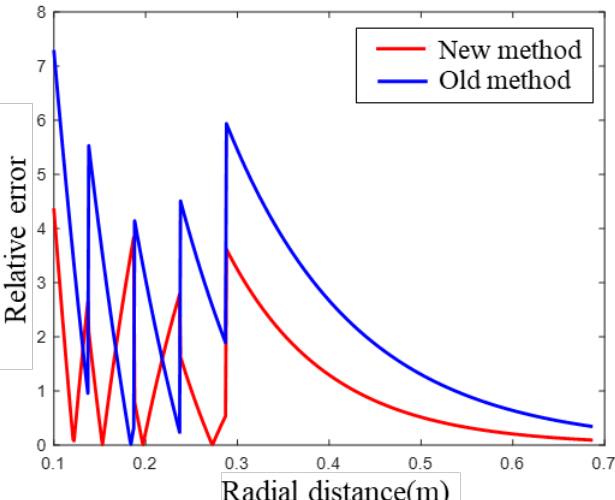
Figure 9. Inversion results using equivalent-tool theory (red line) and without using equivalent-tool theory (blue line).